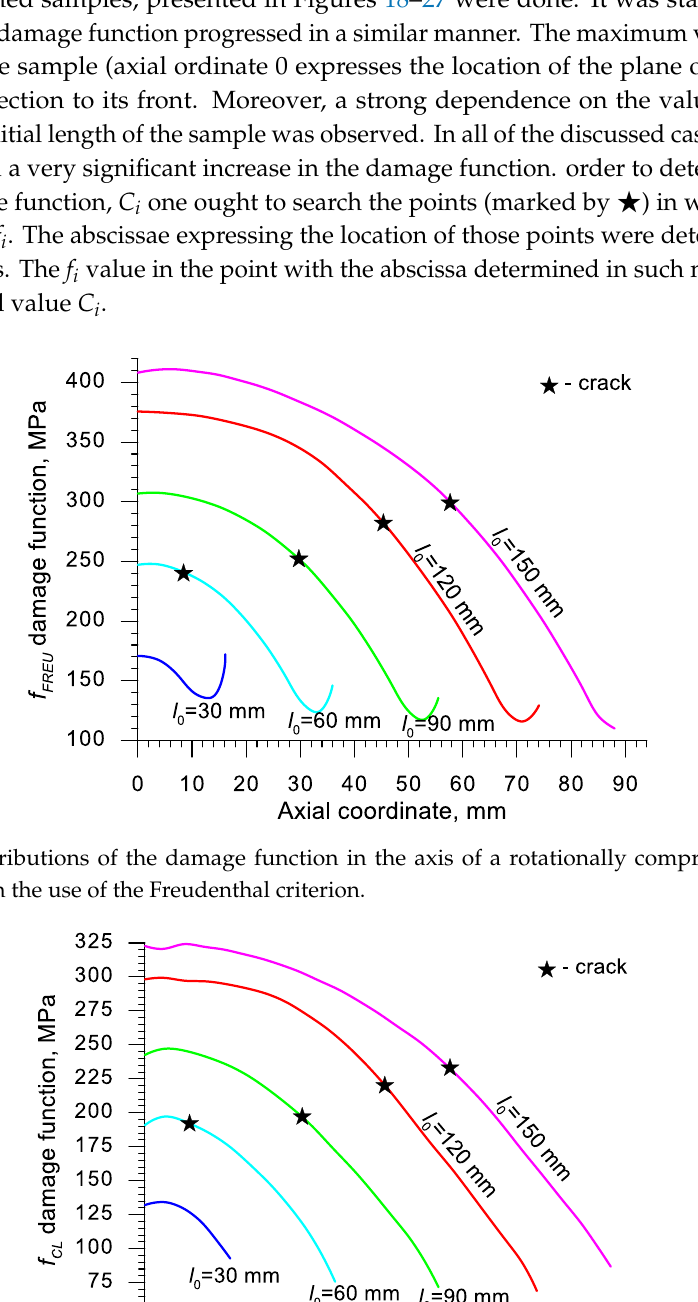
Figure 19. Distributions of the damage function in the axis of a rotationally compressed sample, determined on the basis of the Cockcroft and Latham criterion.